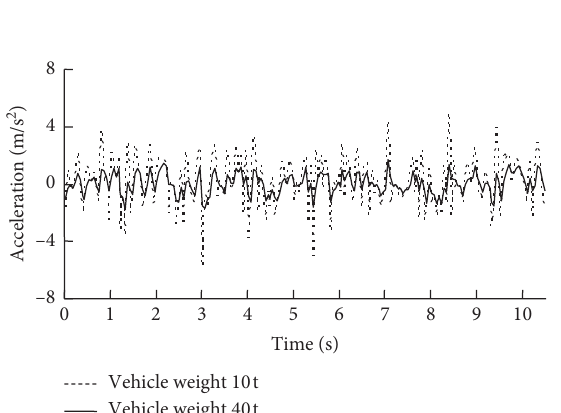
Figure 22: The time-history curves of vertical vibration acceler- ations of the vehicle body.